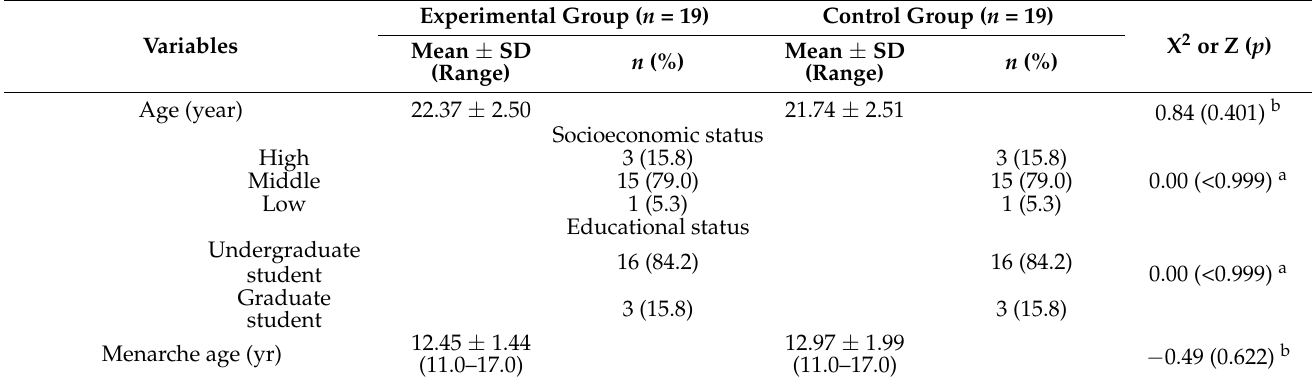
Table 1. General characteristics in the experimental and control groups at baseline ( n =